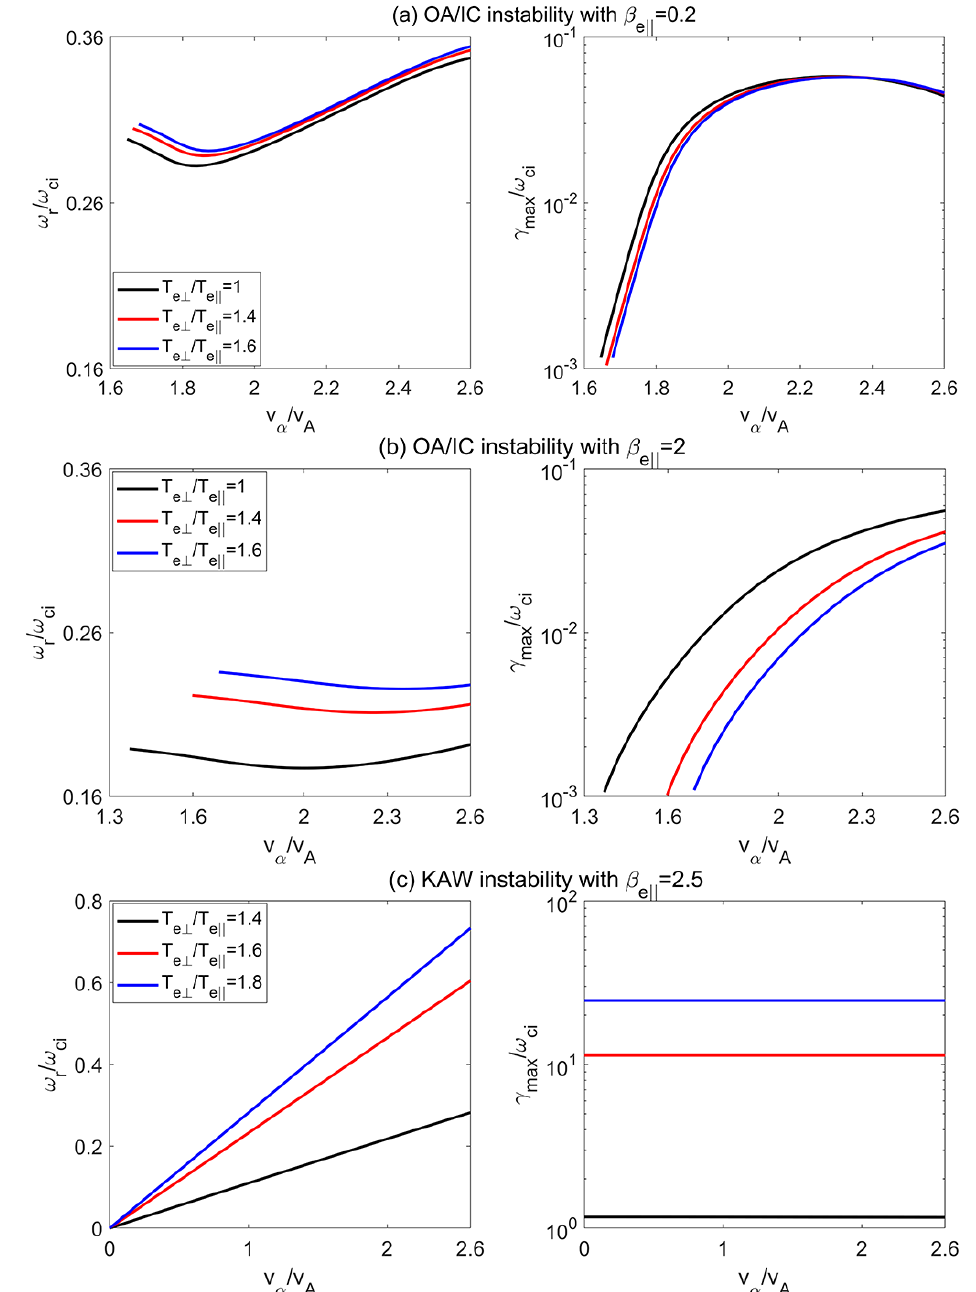
Figure 11. The real frequency ( ω r / ω ci ) and maximum growth rate ( γ max / ω ci ) versus the alpha beam drift velocity ( v α / v A ) for ( a ) the OA/IC instability with β e (cid:107) = 0.2, ( b ) the OA/IC instability with β e (cid:107) = 2, and ( c ) the KAW instability with β e (cid:107) = 2.5. In ( a , b ), the black, red, and blue lines represent electron temperature anisotropies at T e ⊥ / T e (cid:107) = 1, 1.4, and 1.6, and in ( c ), these lines correspond to T e ⊥ / T e (cid:107) = 1.4, 1.6, and 1.8,